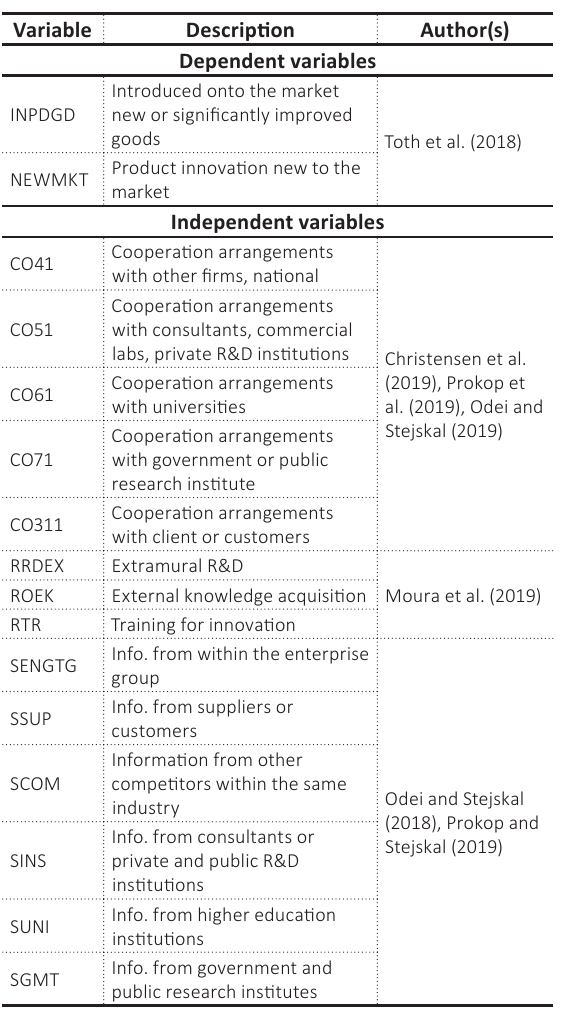
Table 1. Description of dependent and Table 2. Summary of the construct reliability and validity